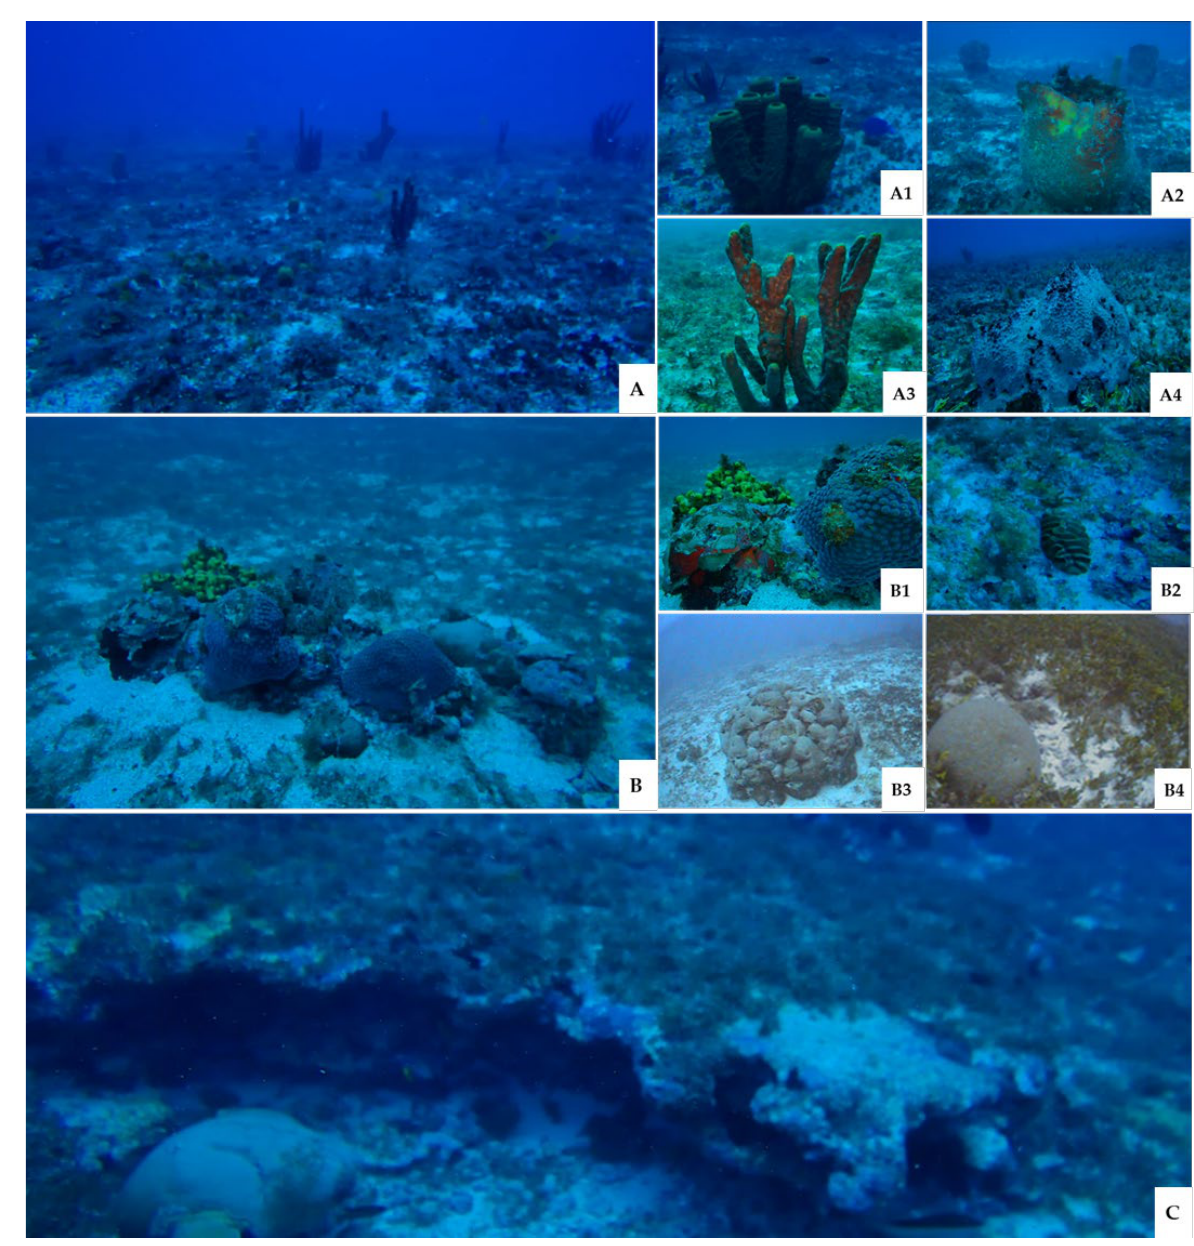
Figure 7. Ecosystems investigated in the mesophotic zone of Marine Protected Area Costa dos Corais using ROVs between 30 and 68 m deep. ( A ) sponge grounds and some representative species: ( A1 ) Aplysina fistularis , ( A2 ) Xestospongia muta , ( A3 ) Aplysina sp., and ( A4 ) Ircinia strobilina ; ( B ) Hermatypicc corals and some representative species: ( B1 ) Montastraea cavernosa , ( B2 ) Meandrina braziliensis ( B3 ), and ( B4 ) Siderastrea spp.; ( C ) beachrock. According to the IUCN’s list of endangered species, none of the corals or sponges found in the area of study are at risk of extinction; however, both Meandrina braziliensis and Mussismilia hispida lack information, appearing as the category “DD” (Table 1).